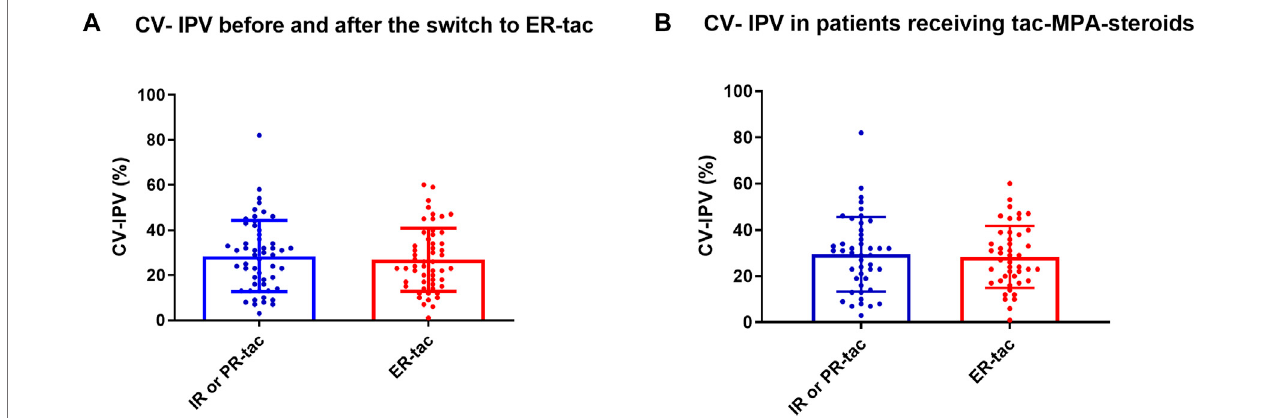
FIGURE 2 | (A) : Correlation between CV-IPV (%) and recipient age, before and after conversion to ER-LCP tacrolimus (the Pearson correlation was r (cid:1) 0.0009, p (cid:1) 0.48 for IR our PR-tac, and r (cid:1) 0.002, p (cid:1) 0.73 with ER-LCP tacrolimus). (B) : CV-tac IPV according to the recipient gender before and after the switch to ER-LCP tacrolimus. IR-tac, Immediate-Release tacrolimus; PR-tac, Prolonged-Release tacrolimus; ER-tac, Extended-Release LCP-tac Resultsare presented asmean withSD. (C) : Correlation between CV-IPV (%) and serum creatinine ( μ mol/L), before and after conversion to ER-LCP tacrolimus (the Pearson correlation was r (cid:1) 0.0002, p (cid:1) 0.90 for IR our PR-tac, and r (cid:1) 0.05, p (cid:1) 0.10 with ER-LCP Tacrolimus).